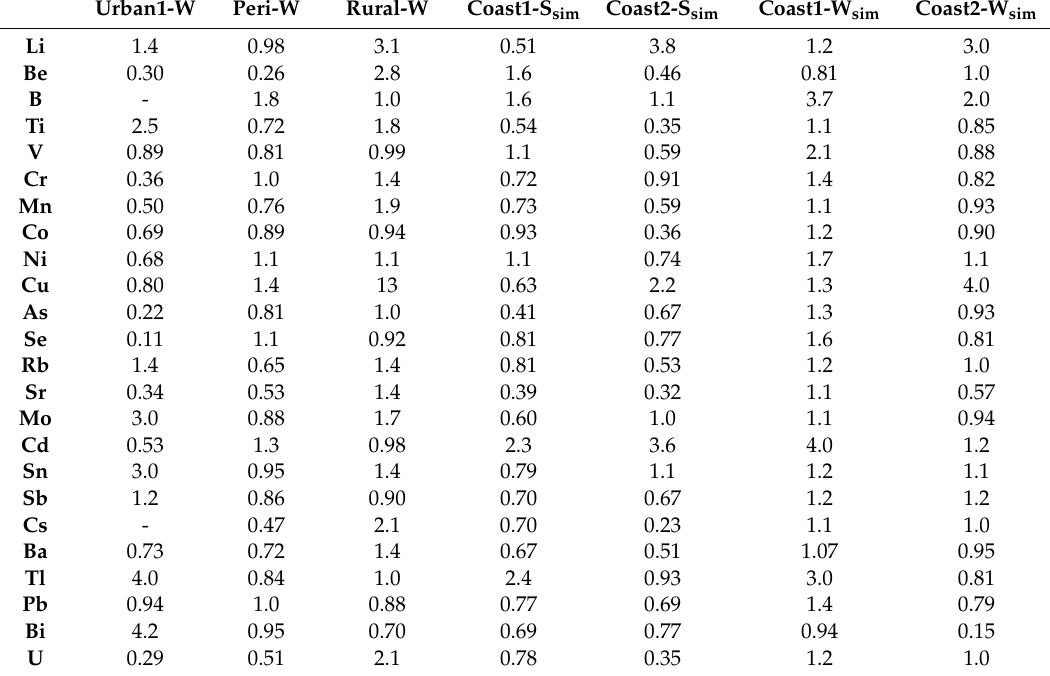
Average indoor-to-outdoor concentration ratios calculated for the residual micro- and